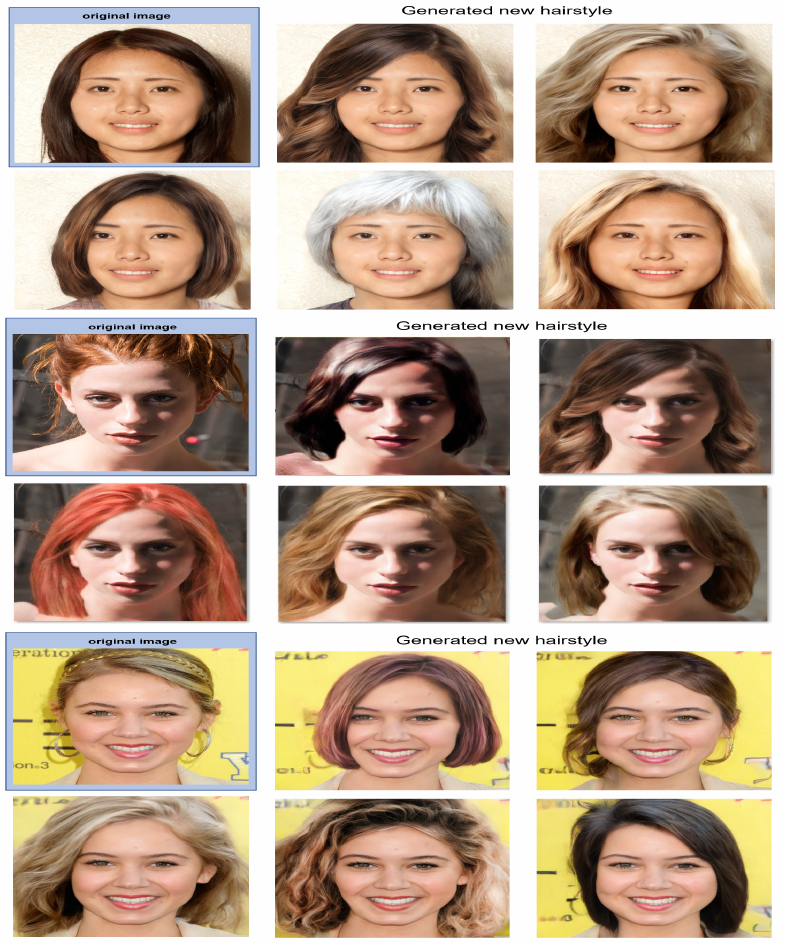
Figure 4. Samples of generated new